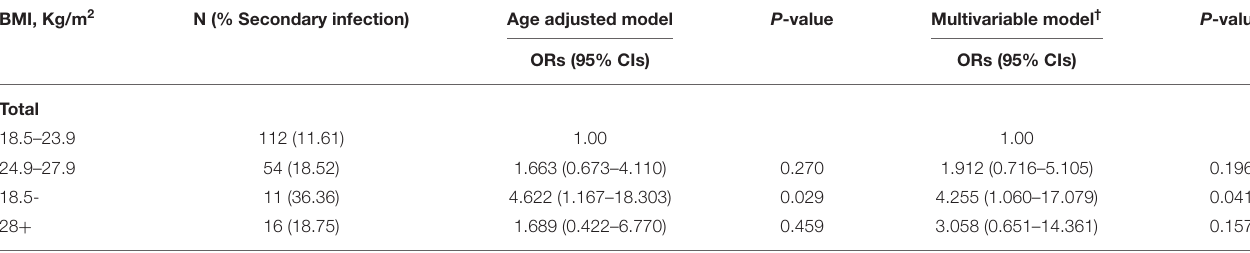
TABLE 2 | Association between body mass index (BMI) and secondary infection on 193 patients with COVID-19. BMI, Kg/m 2 N (% Secondary infection) Age adjusted model P -value Multivariable model †